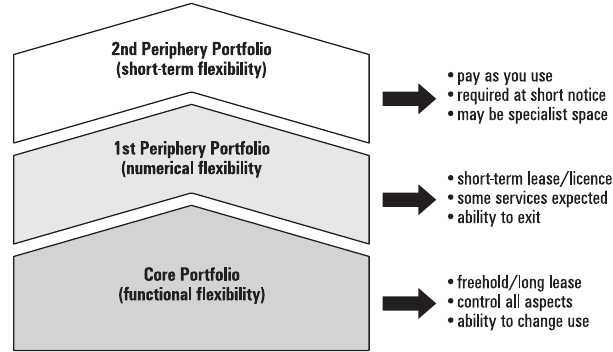
Figure 4. Corporate property